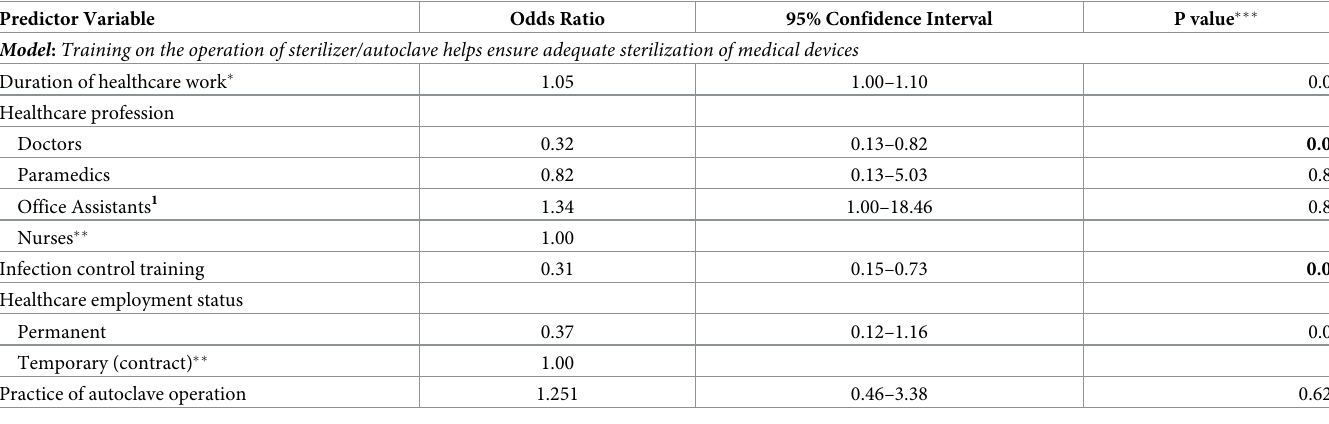
Table 9. Complex samples—ordinal regression model for the attitude of healthcare workers towards training. Predictor